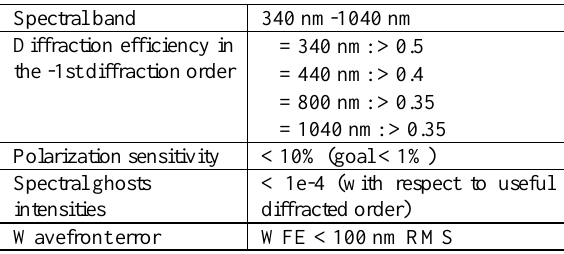
Table 1. Grating requirements related to UV/Vis/NIR